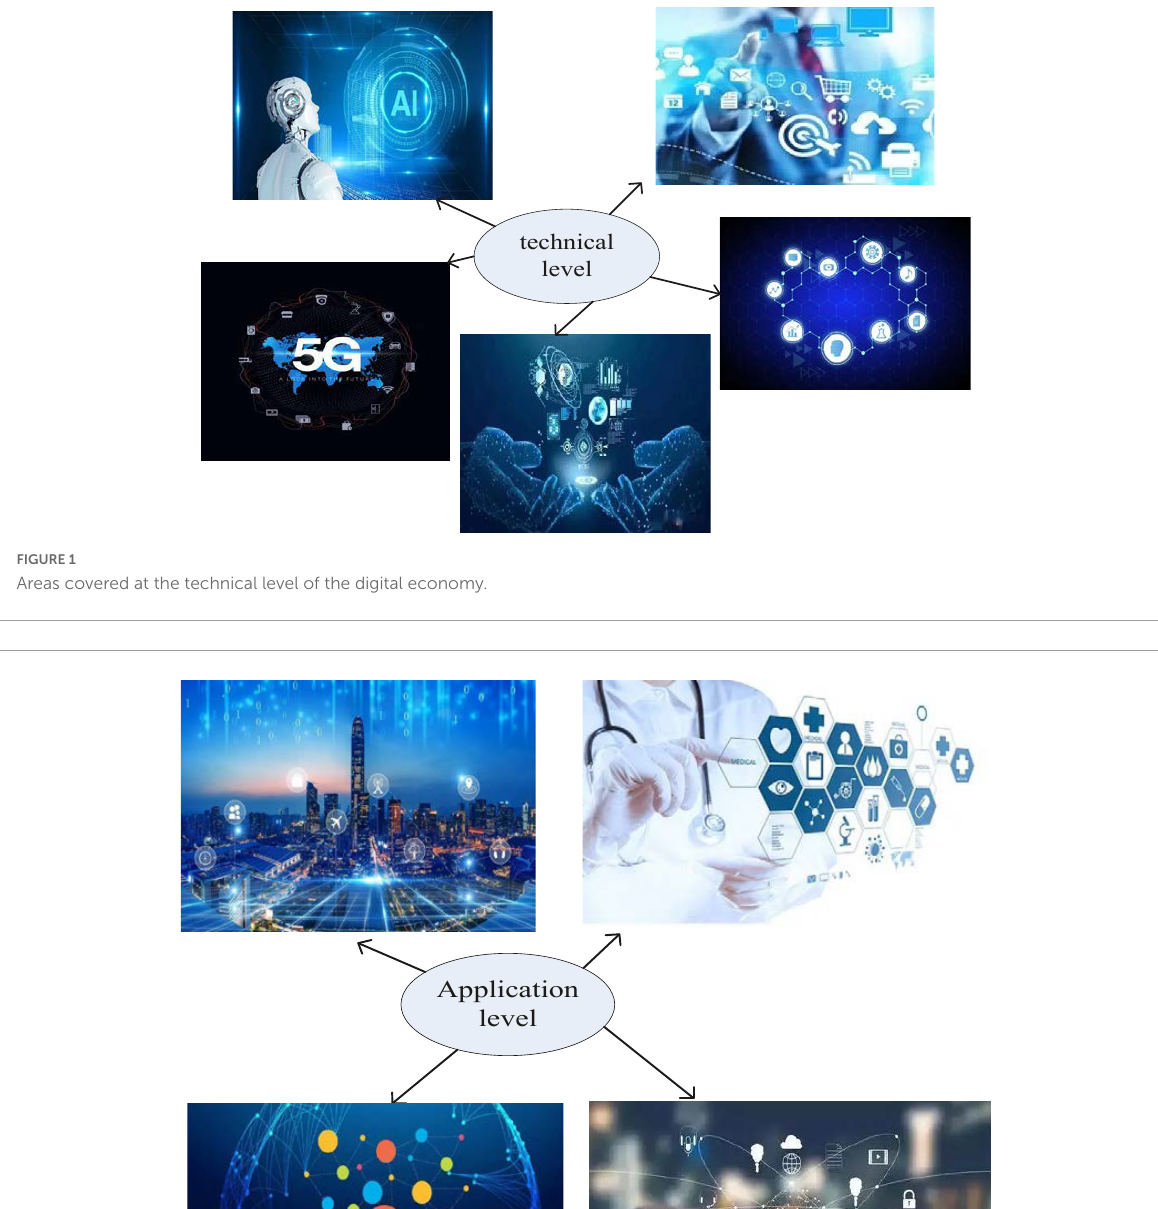
one of the reasons for the popularity of digital